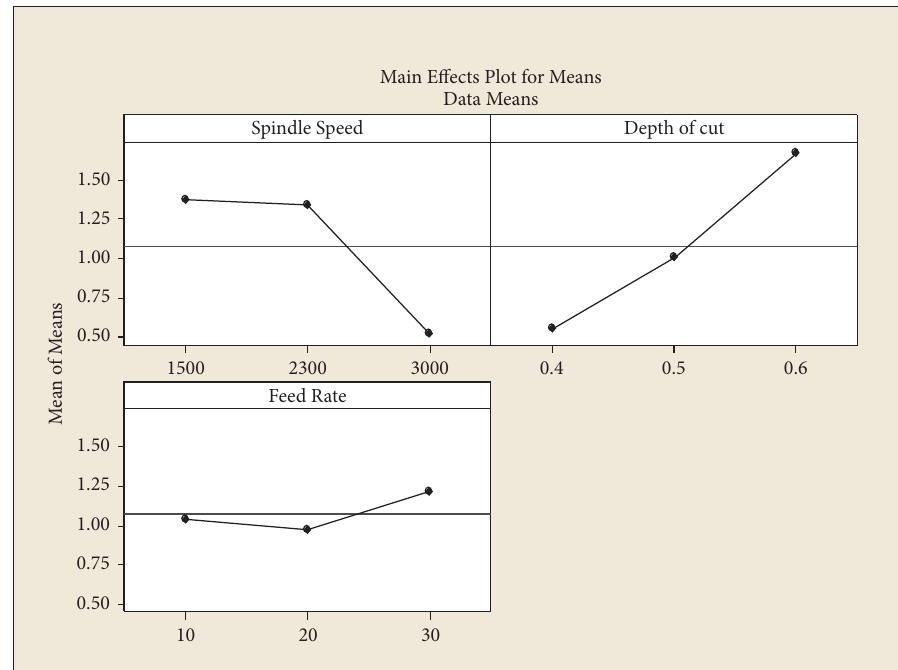
Figure 8: Means plot for MRR-dry runs.